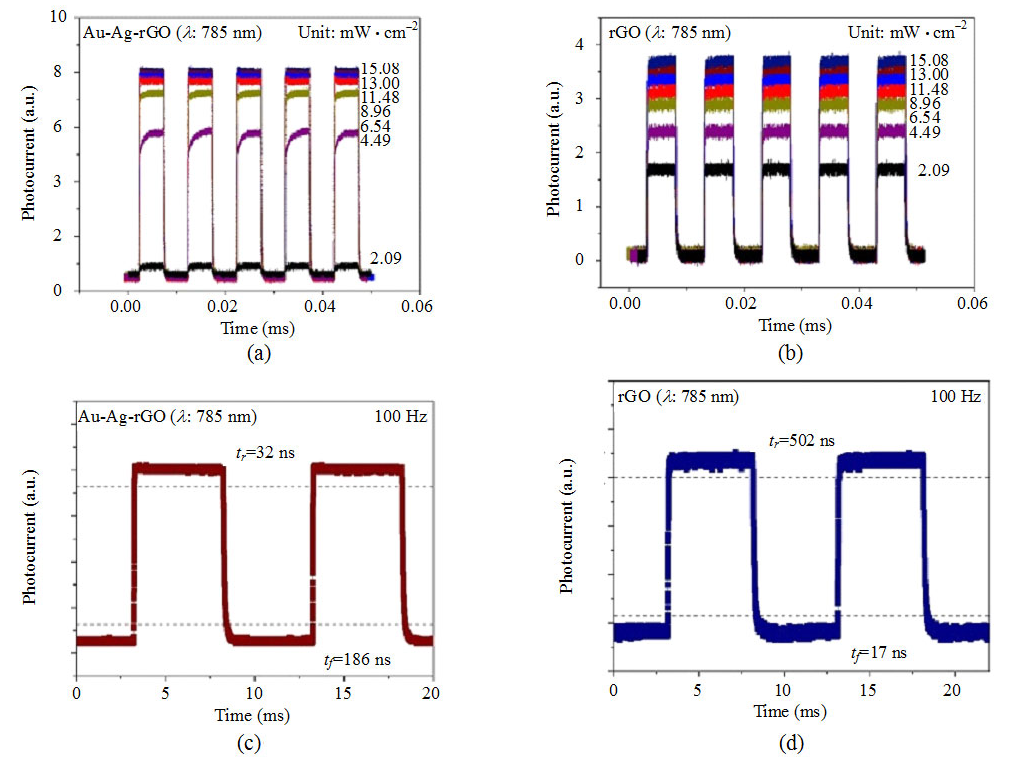
Fig. 7 I - V characteristics: (a) – (b) photoresponse for the BMNP-rGO and bare rGO devices from 2.09 mW  cm − 2 –15.08 mW  cm − 2 ; (c) – (d) rising and falling edges for estimating the rise time ( τ r ) and the fall time ( τ f ) of the devices. All measurements were under the 785 nm laser illumination.